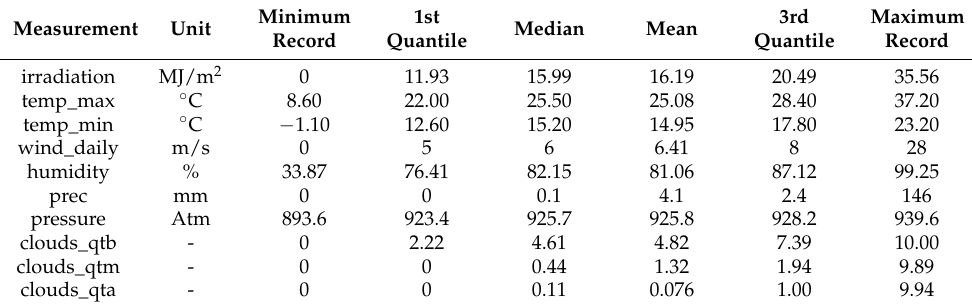
Table 2. Dataset